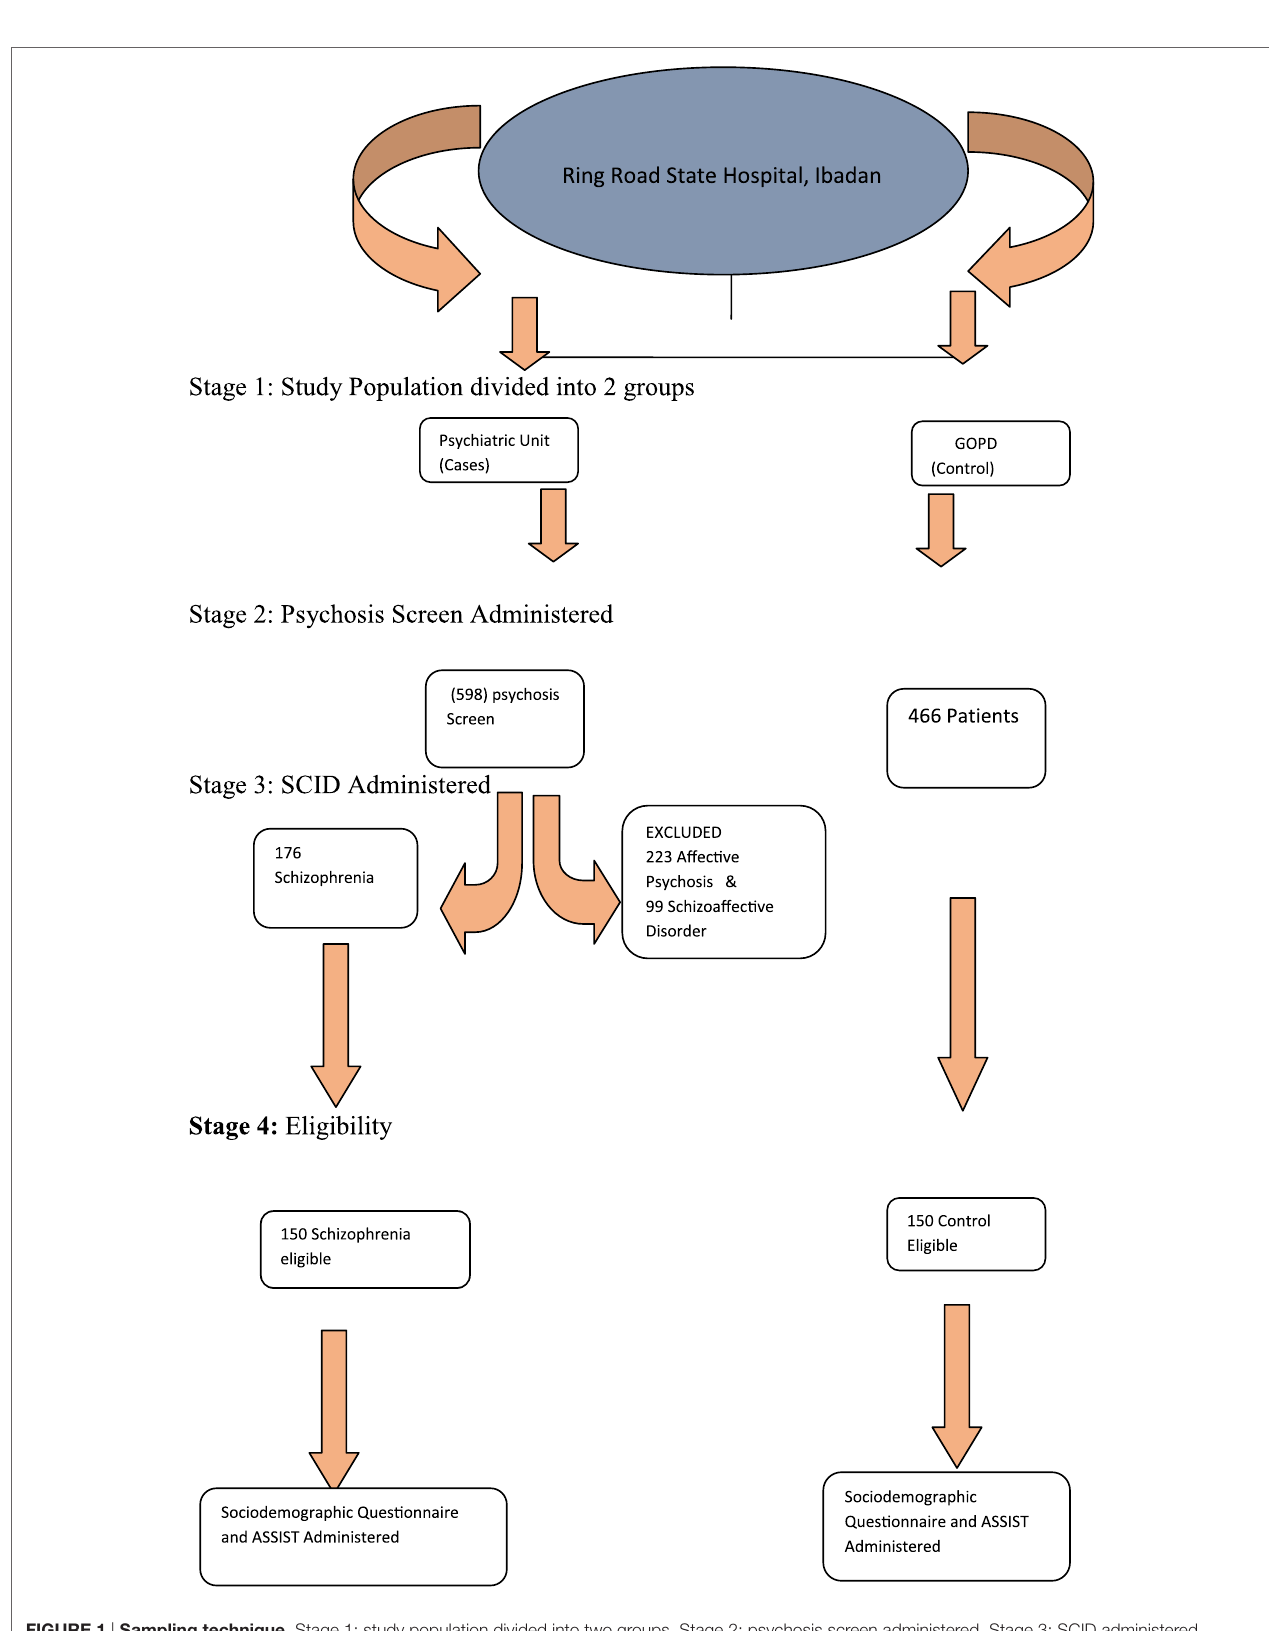
FigUre 1 | sampling technique . Stage 1: study population divided into two groups. Stage 2: psychosis screen administered. Stage 3: SCID administered. Stage 4: